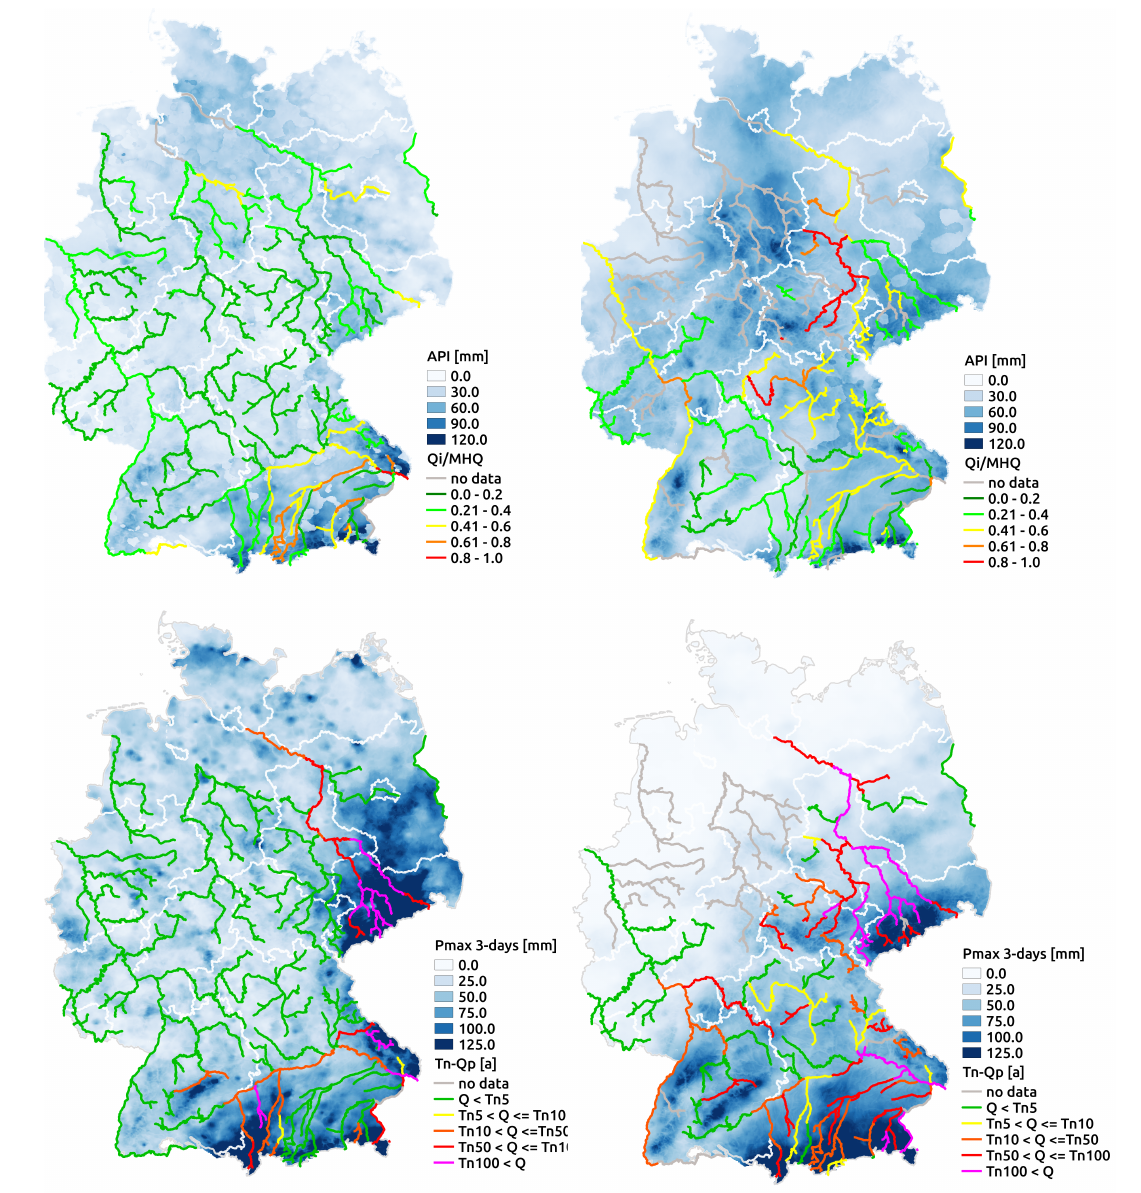
Fig. 1 . Hydro-meteorological characteristics of the August 2002 (left) and the June 2013 flood (right). Top panel: Initial wetness in terms of the antecedent precipitation index (API) and hydraulic load as the ratio of the streamflow at the event start (Qi) and the mean annual flood discharge (MHQ); bottom panel: event precipitation in terms of the maximum precipitation total within 3 days (Pmax 3-days) and the return period of peak discharges